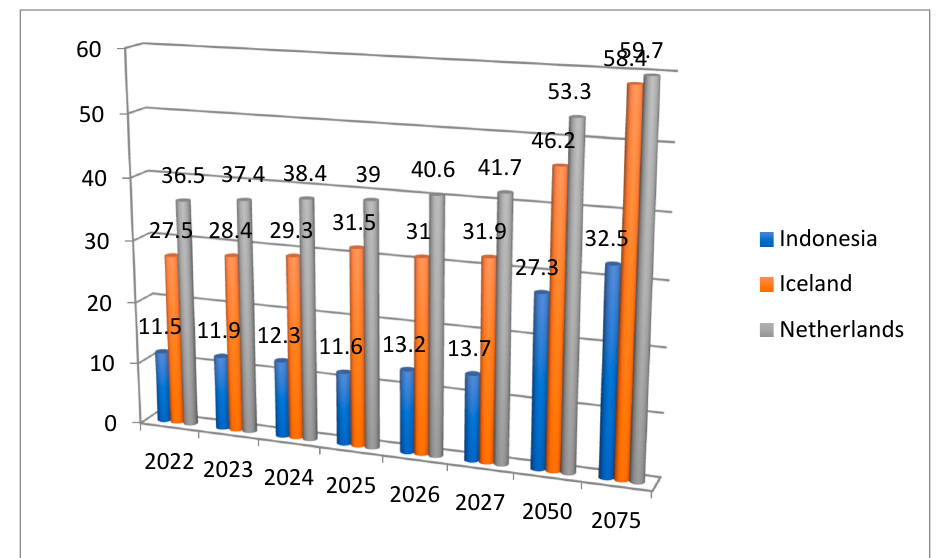
Scheme 3. Old-age dependency ratio in Iceland, the Netherlands, and Indonesia. Source: The World Bank